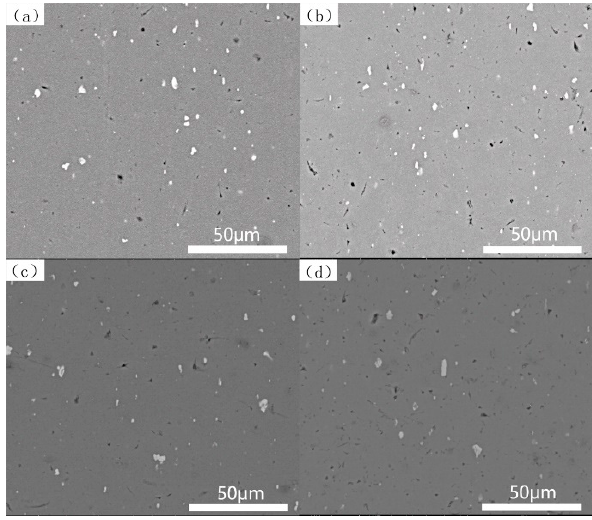
Figure 11. SEM micrographs of the pre-aging specimens: ( a ) 1 h; ( b ) 12 h; ( c ) 24 h; ( d ) 48 h.